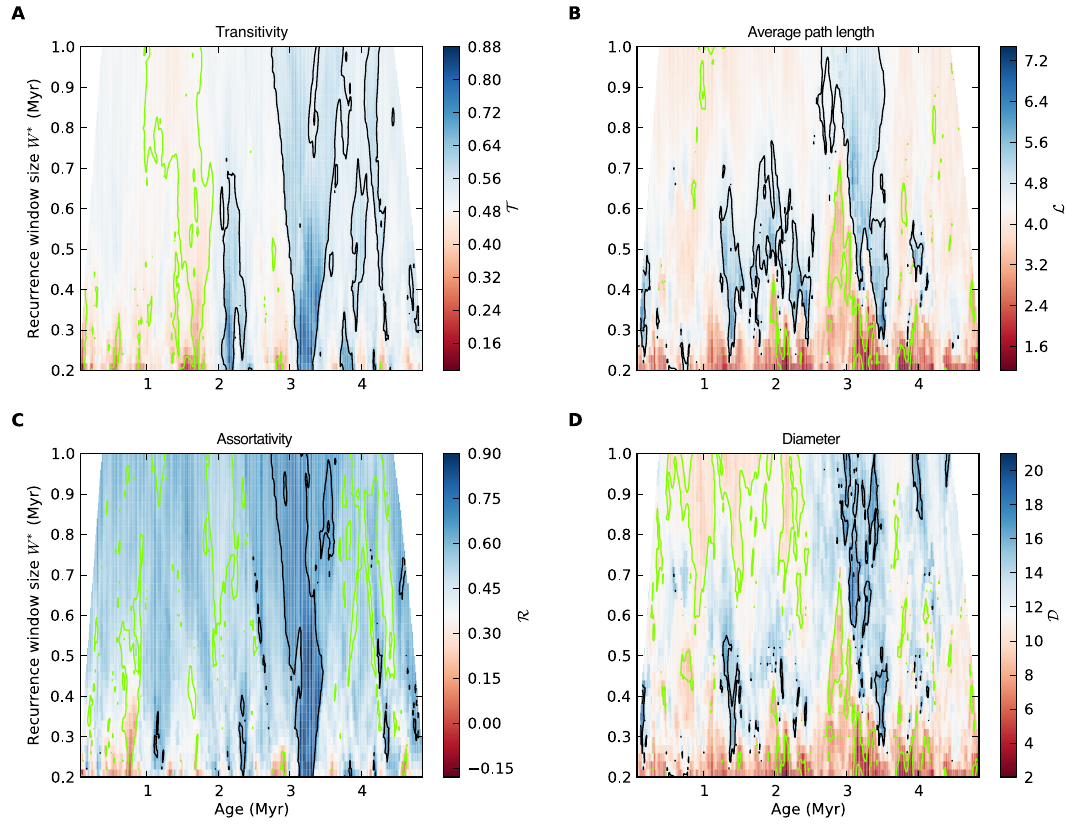
Fig. 13. Dependence of (A) transitivity T , (B) average path length L , (C) assortativity R , and (D) diameter D on the recurrence window size W ∗ for the dust flux record from ODP site 659. The recurrence window step size is fixed to ∆ W ∗ = 41 kyr, the detrending window size to W ∗ D =500 kyr. Green and black contours correspond to the 5% and 95% quantiles with respect to the test distribution obtained from 10000 realisations of our null-model. Other parameters were: embedding dimension m = 3 and delay τ ∗ = 10 kyr, the threshold was chosen to yield a fixed edge density ρ =0 . 05 . The white bands indicating “no value” at the left and right margins of each panel appear because we plot the network measures g µ,W ∗ at the mid-points t µ of the windows µ used for RN analysis (Sec. 2.4). As the mid-points of the first (last) window move further into the past (present) for increasing W ∗ , the white bands grow linearly for linearly increasing W ∗ . of time series analysis, the consideration of embedding with properly chosen parameters is necessary in order to obtain feasible results.